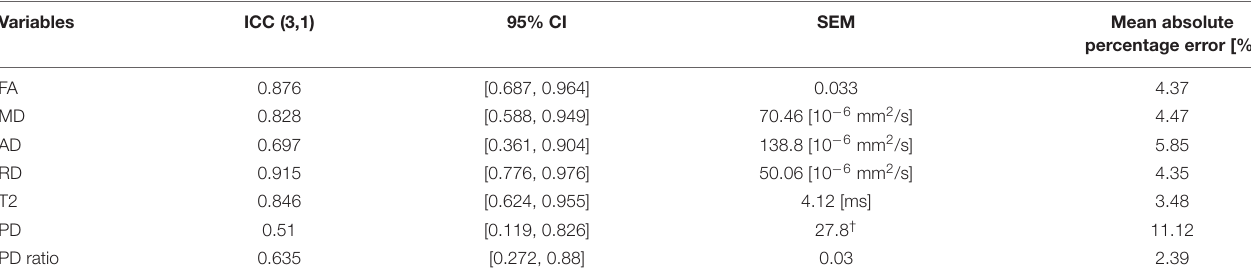
TABLE 2 | Intraclass correlation coefficients (ICCs) and the standard error of measurement